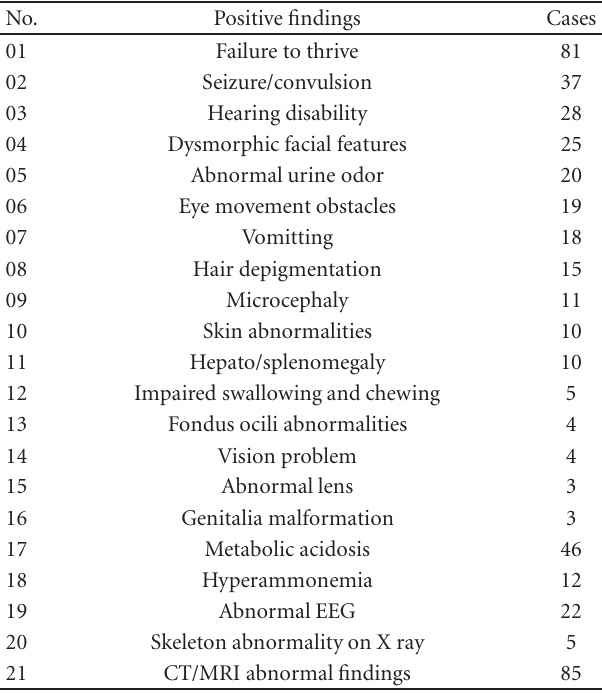
Table 1: Main clinical manifestations besides NDDs and the positive laboratory and imaging findings in syndromic